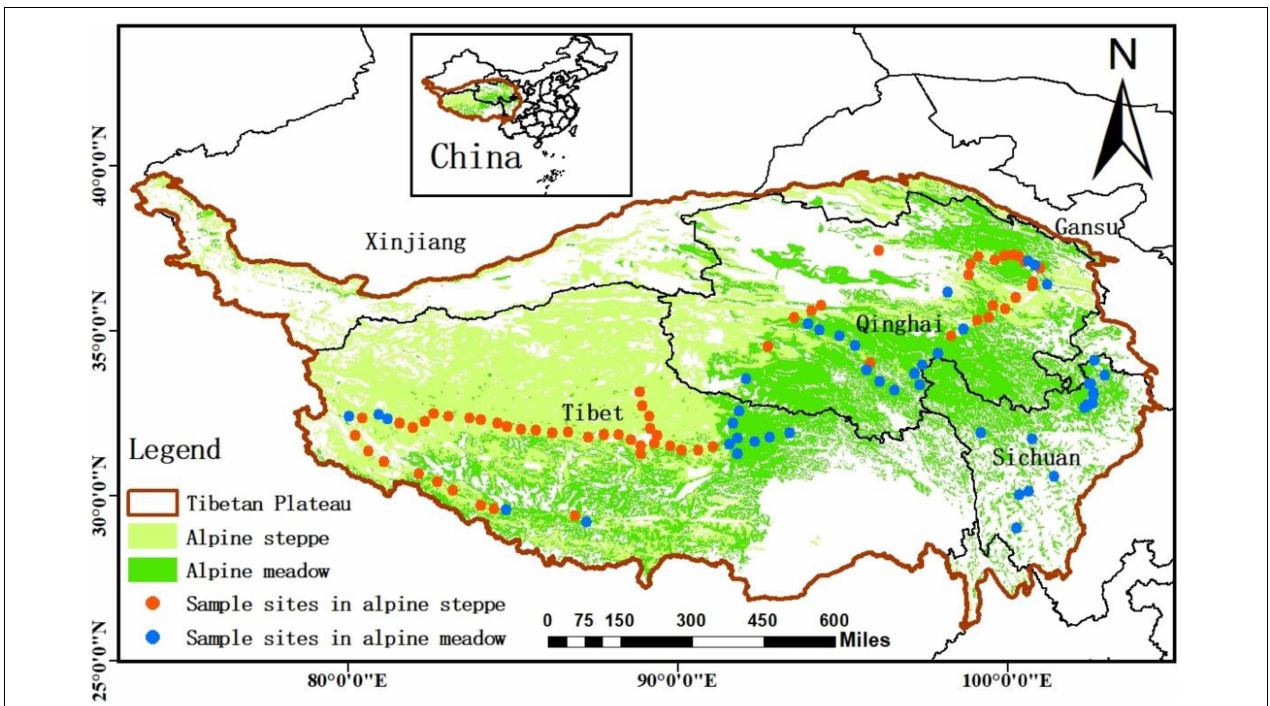
FIGURE 1 | The study area and sample sites. The sample sites (108 sites) were natural zonal grasslands across Qinghai–Tibet Plateau, including alpine meadow and alpine steppe grasslands.